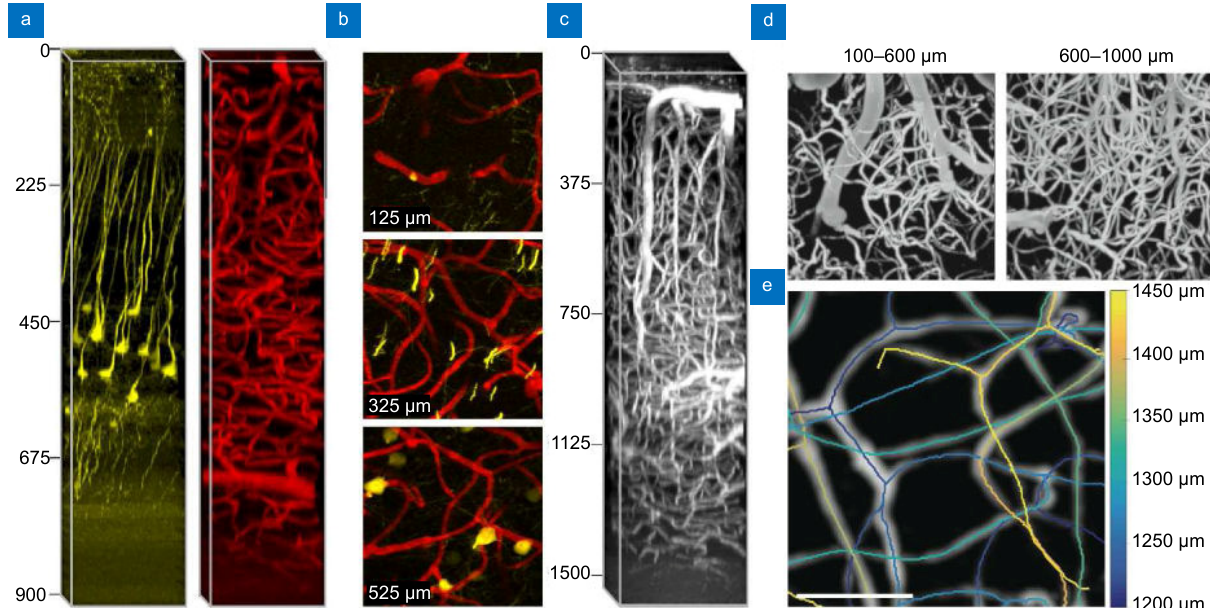
Fig. 4 | Two-photon excited fluorescence imaging of vasculature and neuron in vivo. ( a ) Three-dimensional imaging of layer V pyramidal neurons labeled with yellow fluorescent protein (left) and vasculature labeled with Texas Red (right), and excited by a fiber laser. ( b ) Selected z-sections of the merged stacks in (a). ( c ) Three-dimensional imaging of vasculature labeled with Texas Red, and excited with an optical parametric amplifier. ( d ) z-sections of the stacks in (c). ( e ) Vectorized vasculature in (c). The scale bar is 50 μ m. Figure reproduced from: ref. 43 ,